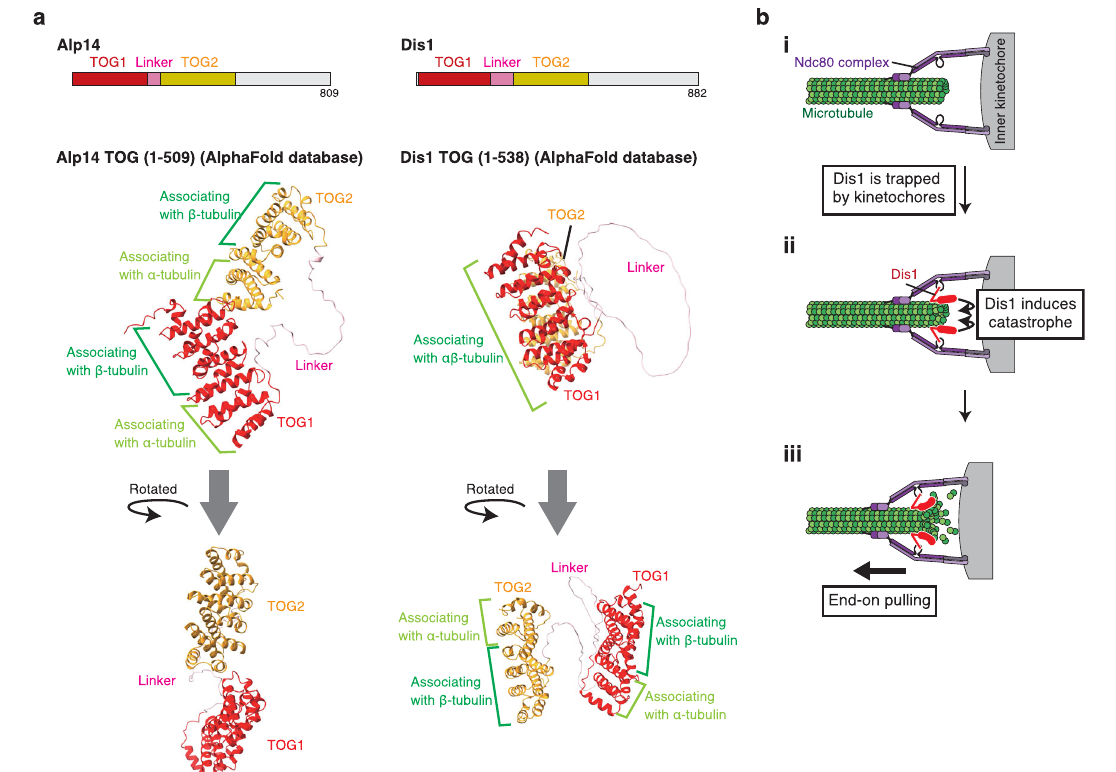
Fig. 6 Comparison of the predicted structures of TOG domains between Alp14 and Dis1. a Predicted structures of the TOG domain of Alp14 (1 – 509 a.a.) and that of Dis1 (1 – 538 a.a.) were referred to the AlphaFold database (https://alphafold.ebi.ac.uk/) 47 . Domains for TOG1, linker and TOG2 are shown in red, pink and yellow, respectively, using ChimeraX v.1.2.5. (UCSF) 69 . The style of association between tubulin dimers and each TOG was adapted from a previous study on Alp14 crystallography 45 . b Possible schemes representing kinetochore retrieval by Dis1. First, the kinetochore attaches to the microtubule, which does not actively promote catastrophe (i). Upon reaching the microtubule tip, Dis1 is trapped by kinetochores and induces catastrophe (ii), which triggers microtubule shrinkage, thereby retrieving the kinetochore